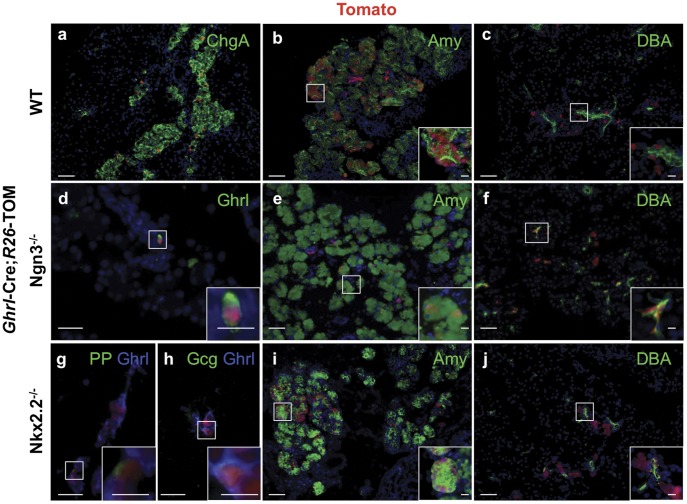
Ghrelin lineage-labeled cells are frequently found in the pancreatic exocrine and ductal compartments in neonates.Ghrelin-lineage labeled Tom+ cells predominantly localize to the islet periphery (a). Approximately 50% of the embryos analyzed contained ghrelin-labeled cells within the amylase+ acini clusters (b). This phenomenon is preferentially observed in juxta-duodenal regions of the ventral pancreas. (c) Ghrelin-lineage labeled cells that co-expressed ductal markers were also identified in the same animals. In Neurog3−/− pancreata (d–f), which are almost completely devoid of endocrine hormone-producing cells, we could detect a small number of ghrelin-expressing and lineage labeled cells (d). We also detected ghrelin descendants in the exocrine (e) and ductal tissue (f) of Neurog3−/− embryos. (g–j) In Nkx2.2−/− mice, a subset of Ppy- (g) and glucagon-expressing cells (h) are still derived from ghrelin-expressing cells. Ghrelin-labeled cells are also detected in the exocrine and ductal compartment of Nkx2.2−/− animals (i–j). The frequency and magnitude of lineage labeling of these cells were not significantly different from wild type pancreas. a, d and e are representative images of at least 3 pancreata. b, c, f, g, h, i, j are representative image of at least 3 embryos in which we detected labeled cells localized to the exocrine and ductal pancreatic tissue. All images are from Ghrl-Cre;R26-TOM P0 pancreas in the indicated genetic backgrounds. DAPI staining was used to visualize the nuclei. Scale bar: all panels = 50 µm, insets = 10 µm.